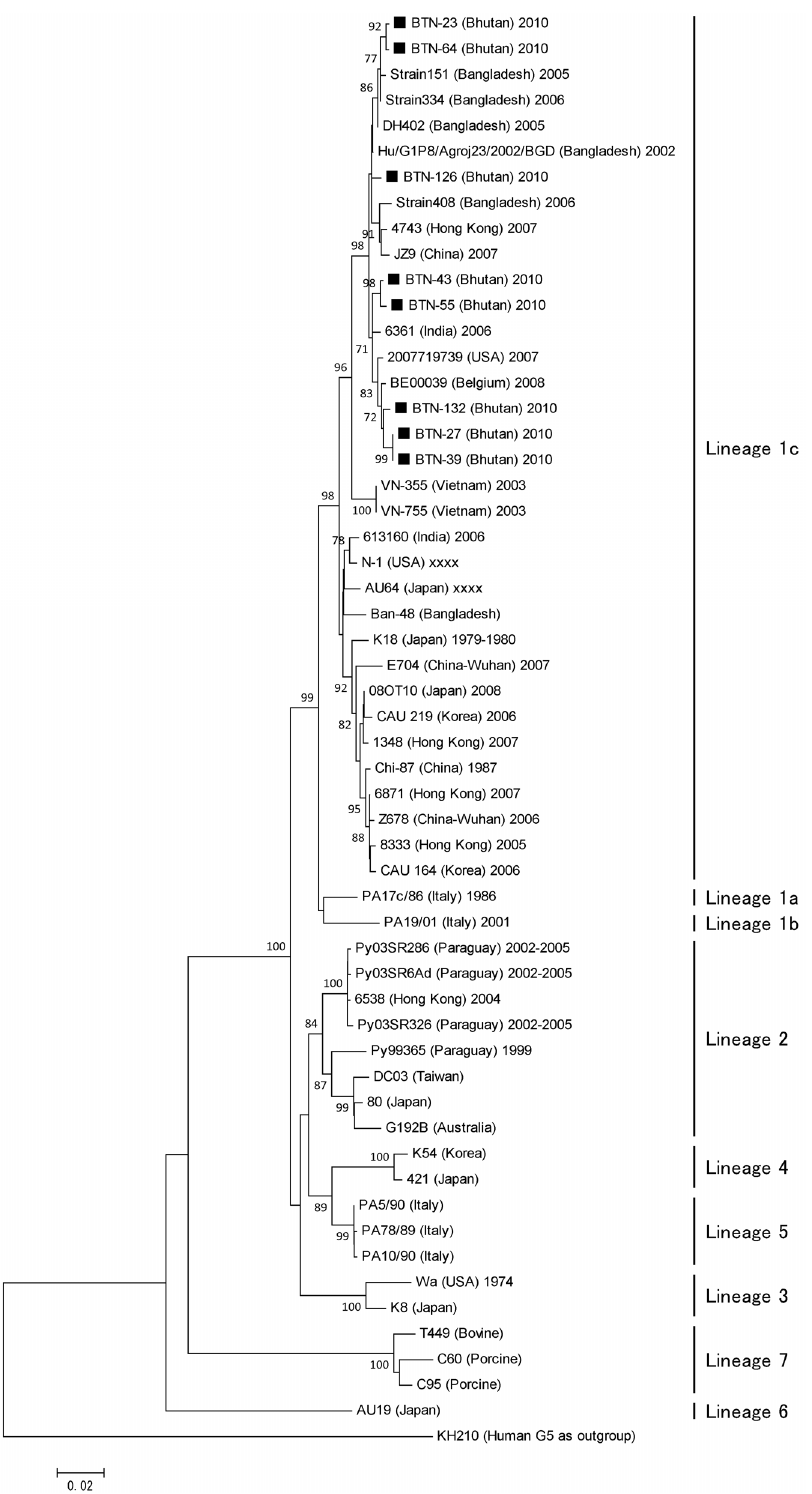
PLOS ONE | www.plosone.org